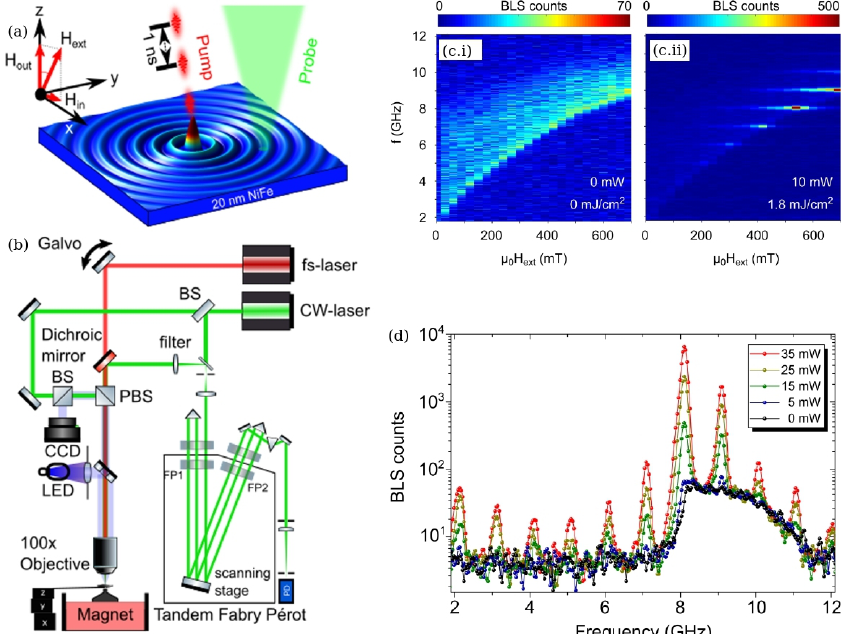
Figure 8. Illustration of the generation of a magnonic BLS-based FC. ( a ) A ferromagnetic thin film sample is pumped with a red (816nm wavelength) 120fs-long pulsed laser light and probed using a continuous green laser (532nm) light. The direction of the external magnetic field H ext applied to the sample is indicated. ( b ) Schematic of the optical setup of the pump-probe experiment, where BS denotes a 50/50 beam splitter and PBS is a polarising beam splitter. The sample is placed right below a microscope objective to achieve diffraction-limited focusing. The backscattered light is analysed using a six-pass tandem Fabry–Pérot interferometer (TFPI) and detected using a single-channel avalanche photodiode (APD). False-colour maps of thermally excited spin wave spectra as a function of the applied magnetic field without ( c.i ) and with ( c.ii ) irradiation with an fs-laser pulse train at a 1.8mJ/cm 2 fluence. ( d ) BLS counts as a function of frequency at an applied magnetic field magnitude of 600mT for four different laser powers. The thermal spin wave background is also shown. Reproduced from [18] published by the American Physical Society under the terms of the Creative Commons Attribution 4.0 International